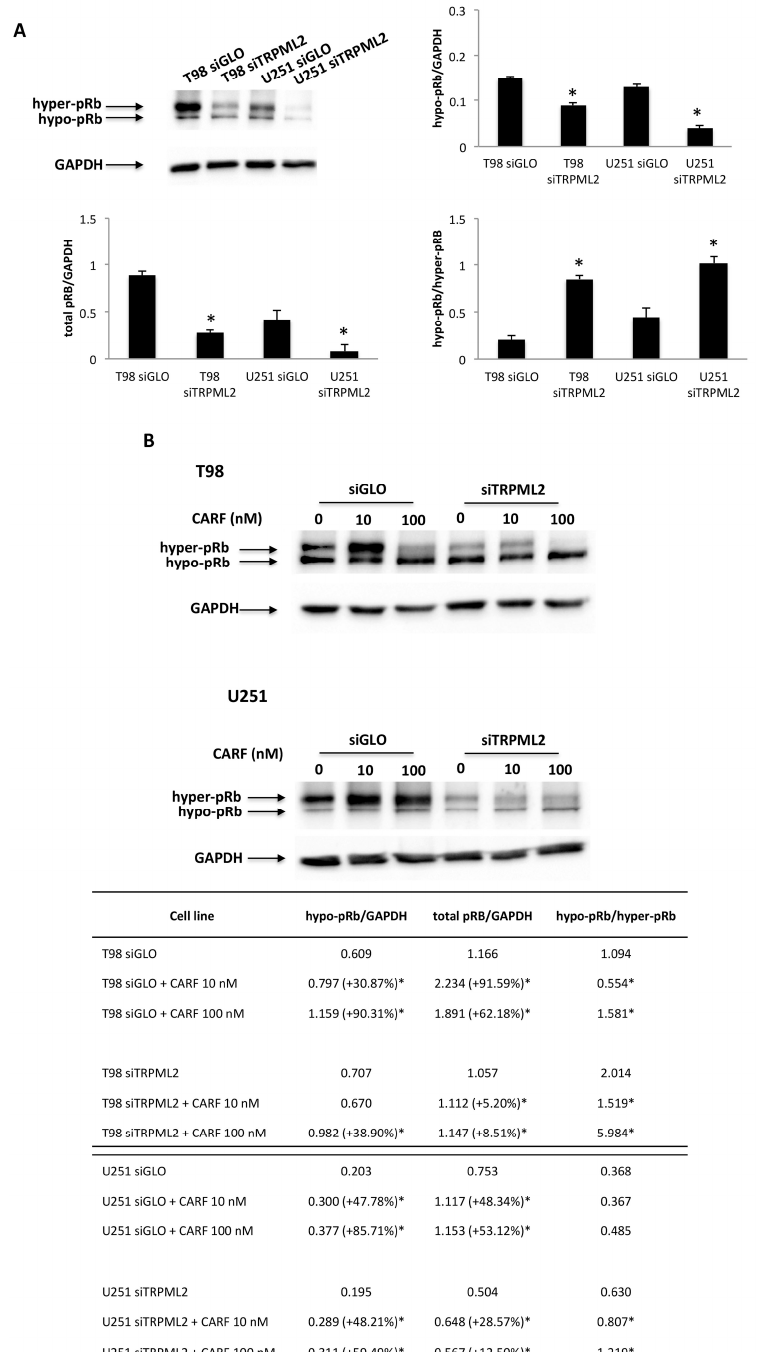
Figure 7. TRPML2 silencing reduces pRB1 levels and the proteasome inhibitor Carfilzomib partially reverts this inhibitory effect in T98 and U251 cell lines. ( A ) Representative immunoblot regarding pRB1 in siGLO and siTRPML2 T98 and U251 cell lines 48 h post-transfection. Blots are represen- tative of one of three separate experiments. Densitometry values were normalized to GAPDH, which was used as a loading control. Data are expressed as themean ± SE of three separate exper- iments. * p < 0.05 siTRPML2 vs. siGLO. ( B ) Representative immunoblot regarding pRB1 in CARF (Carfilzomib)-treated siGLO and siTRPML2 T98 and U251 cells. Blots are representative of one of three separate experiments. Densitometry values were normalized to GAPDH, which was used as a loading control. Data are expressed as the mean ± SE of three separate experiments. * p < 0.01 CARF vs.